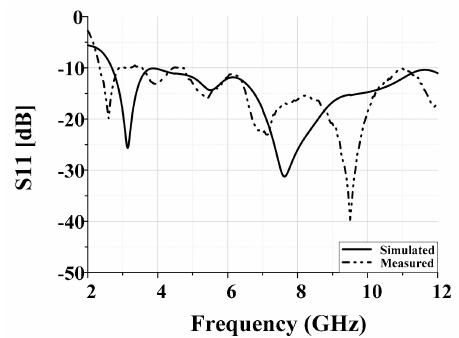
Figure 15. Measured and simulated reflection coe ffi cient characteristics of the fabricated UWB antenna.